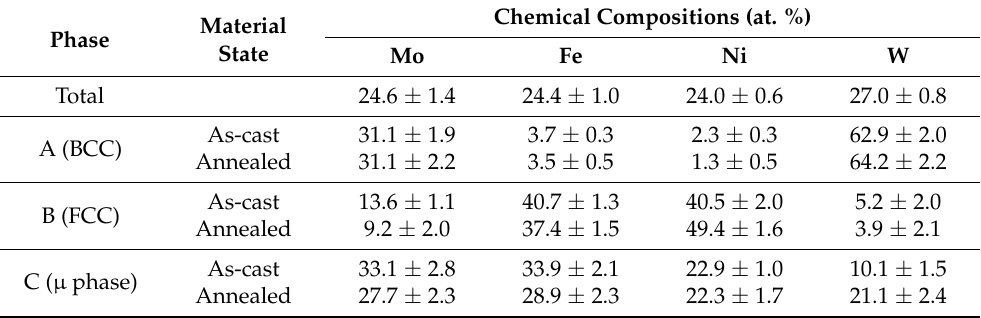
Table 1. The composition of three phases in HEA. Chemical Compositions (at. %) Material Phase State Mo